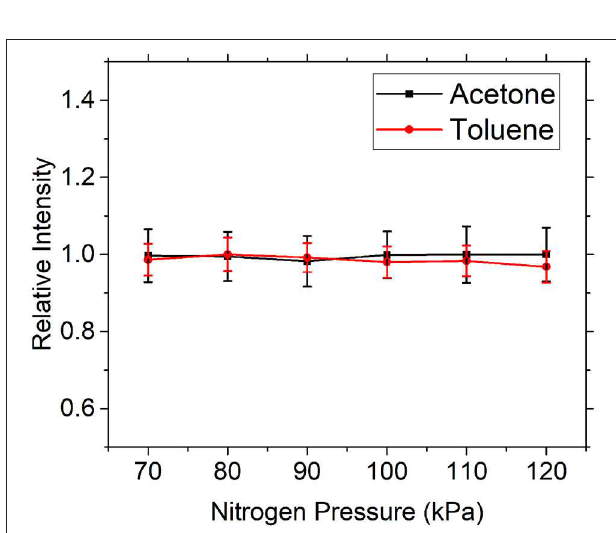
FIGURE 4 | The influence of nitrogen partial pressure on acetone (black) and toluene (red) fluorescence